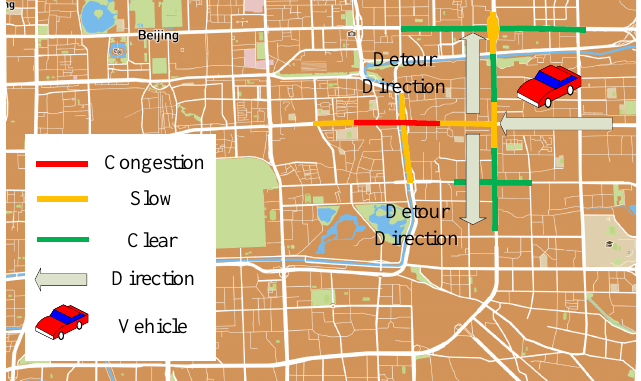
Figure 1. A detour diagram of city